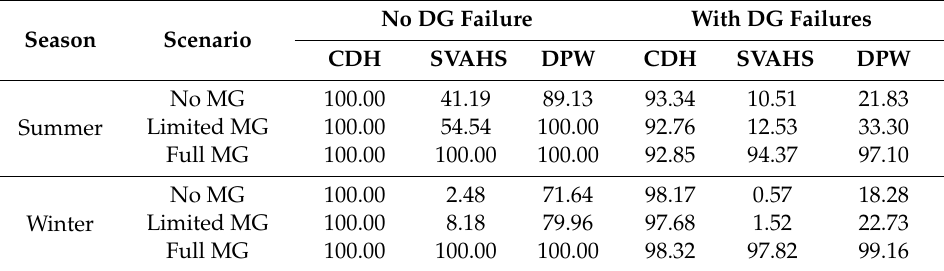
Table 15. Mean survival rates of the system without CDH PV in 7 days outages.